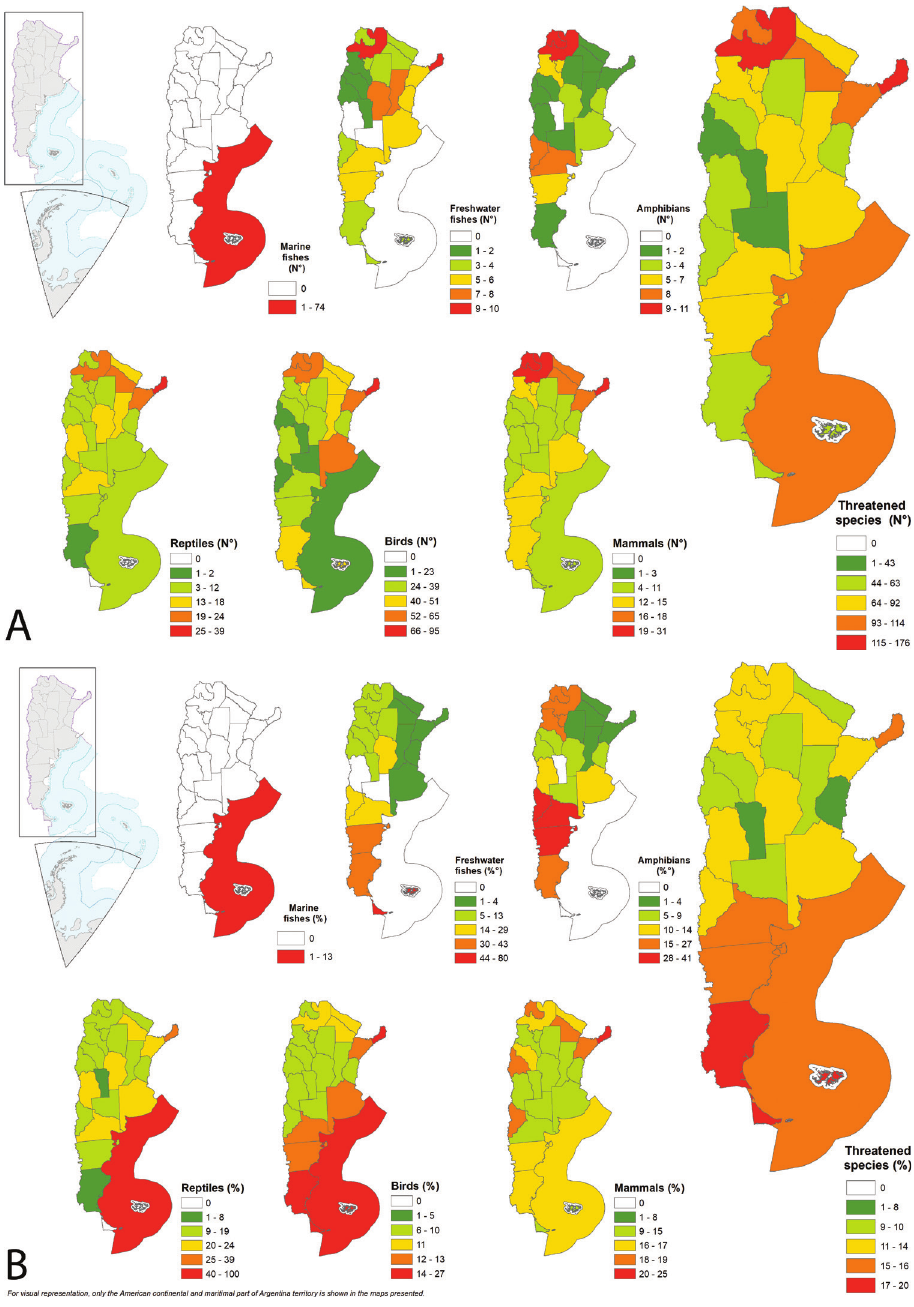
Figure 4. Threatened species by taxonomic group and province A number of threatened species by taxonomic group and total number of total threatened vertebrate species in each province B percentage of threatened species over the number of total native species of each taxonomic group present in the province and total threatened species in each province as a percentage of total vertebrate